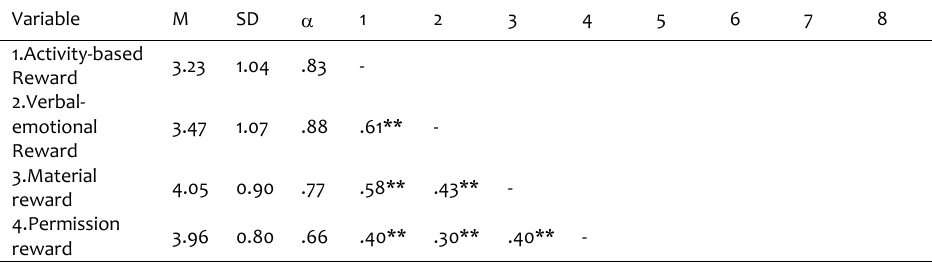
Table 2. Summary Data and Bivariate